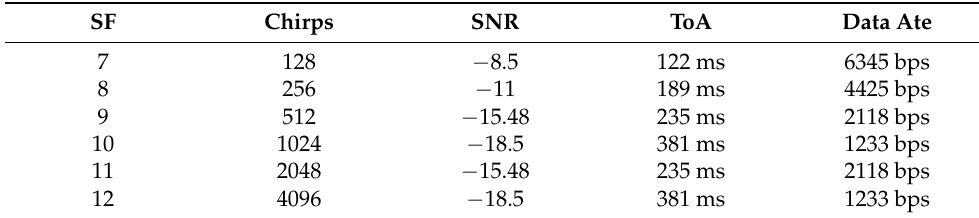
Table 4. Range and link budget at node sensitivity—124 dBm.